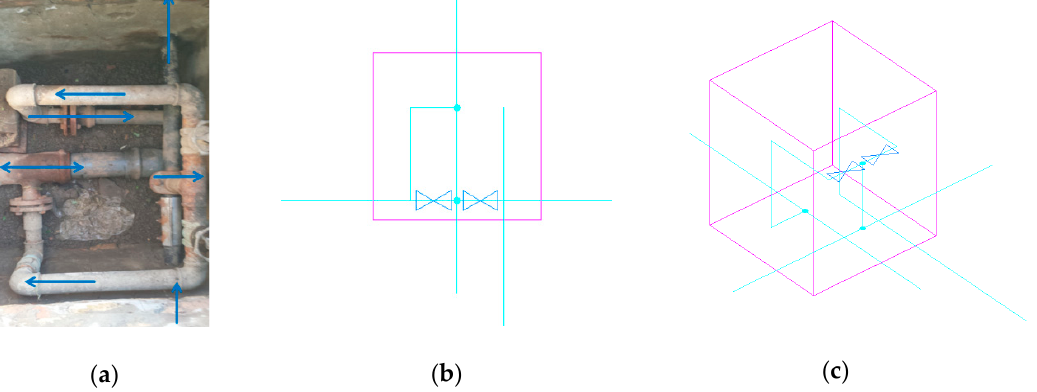
Figure 10. Water pipes. ( a ) A photo of a shaft with water pipes; ( b ) a 2D representation of the water pipes; ( c ) a 3D representation of the water pipes.